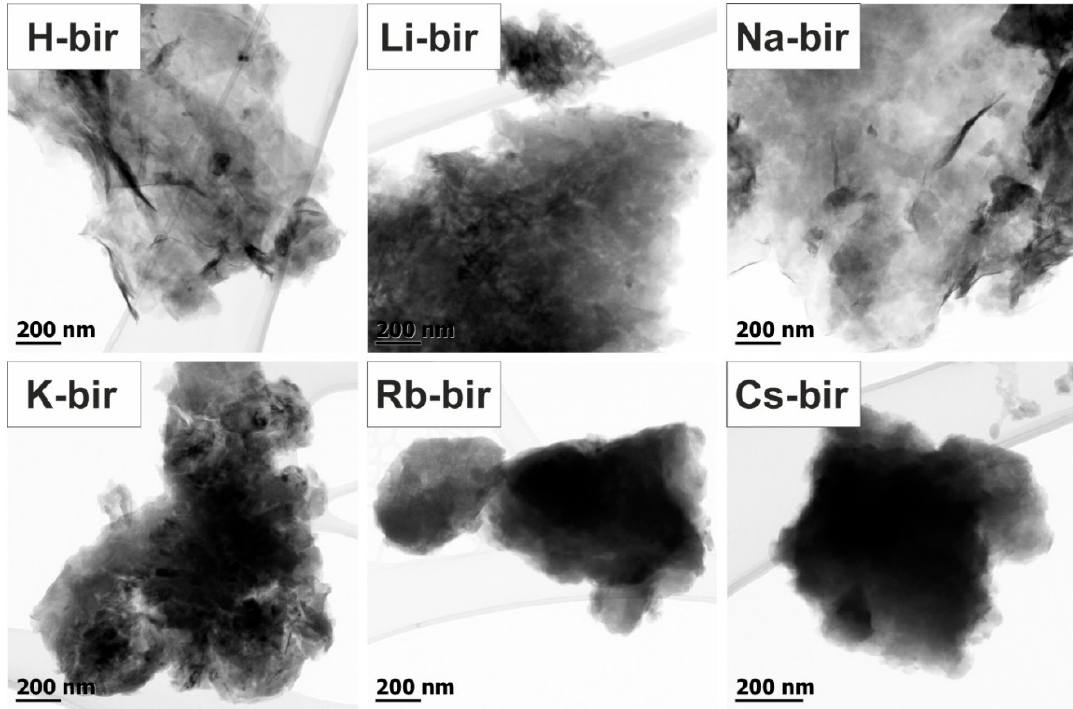
Figure 4. TEM overview images of the bulk alkali-promoted birnessite catalysts.